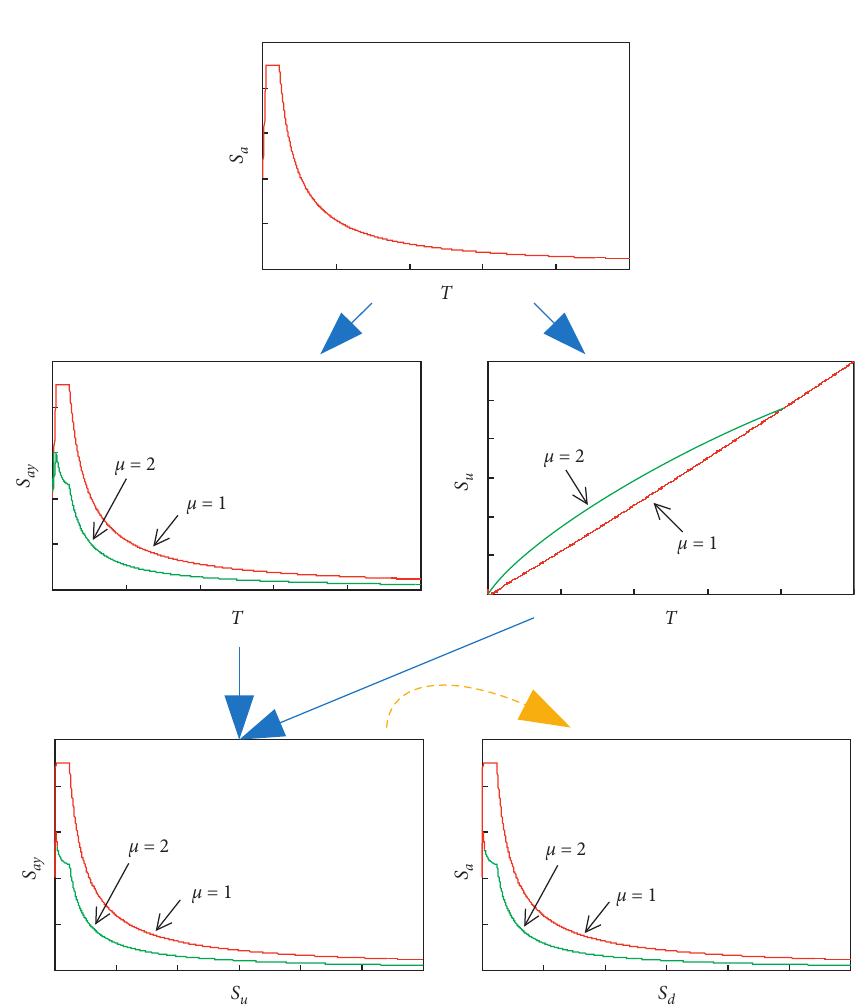
Figure 4: Generation procedure of the inelastic demand